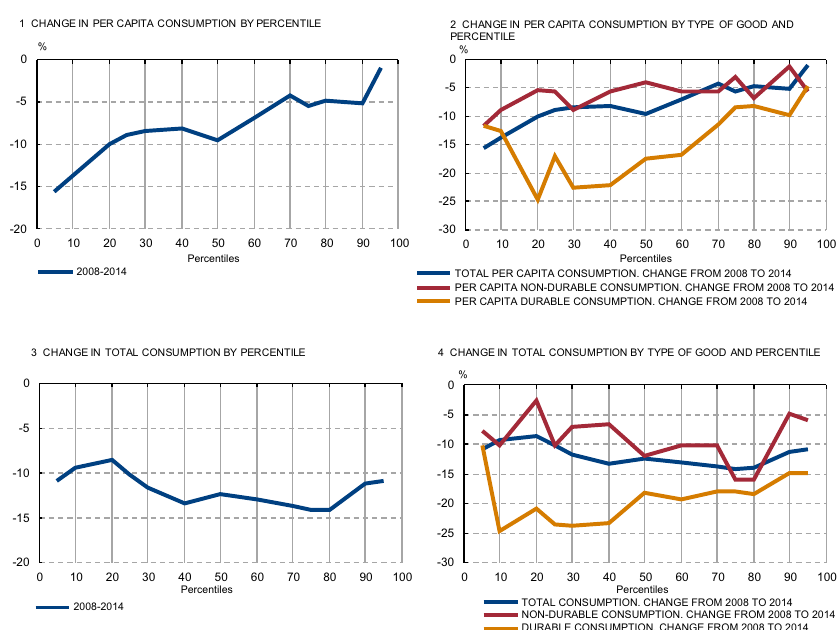
Fig. 13 Change in consumption by percentile and type of goods consumed. Source : Banco de España (EFF)